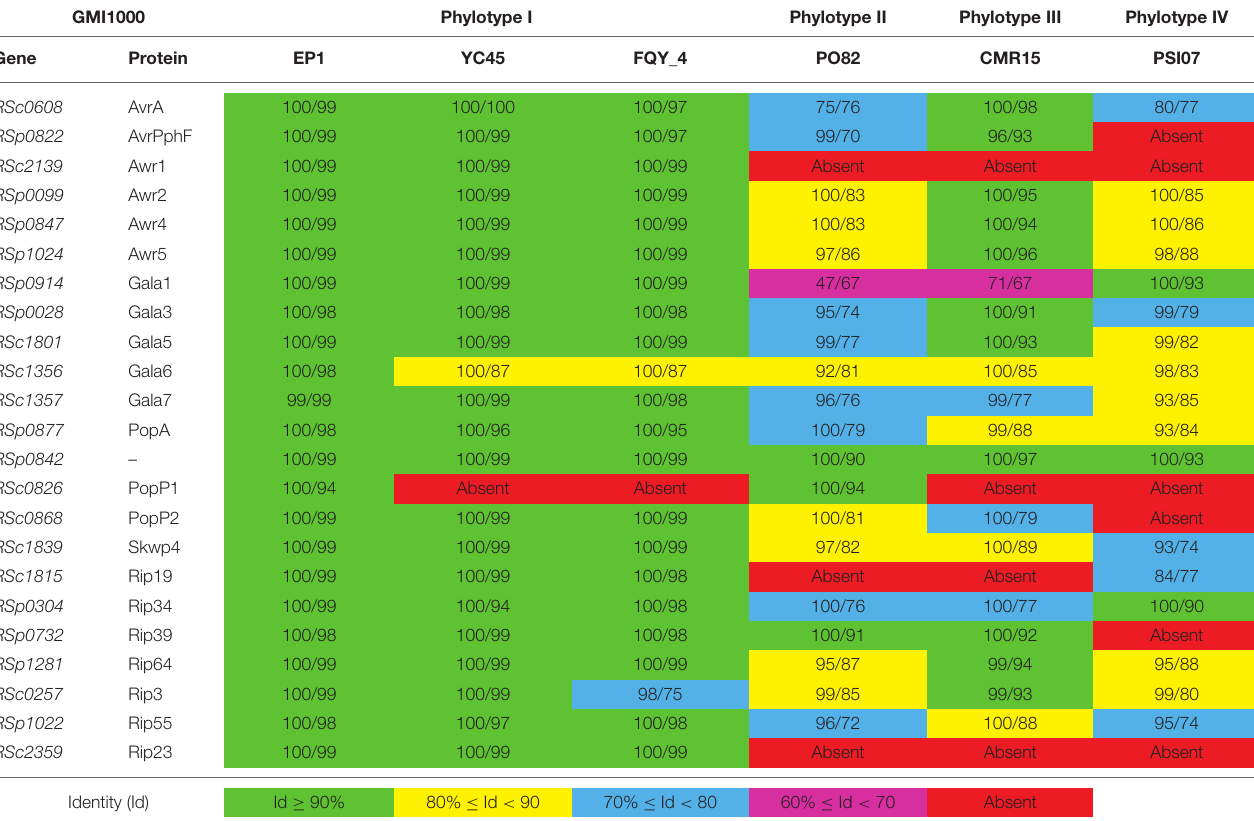
TABLE 3 | Coverage (%)/Identity (%) comparison with defined role T3es genes of R. solanacearum strain